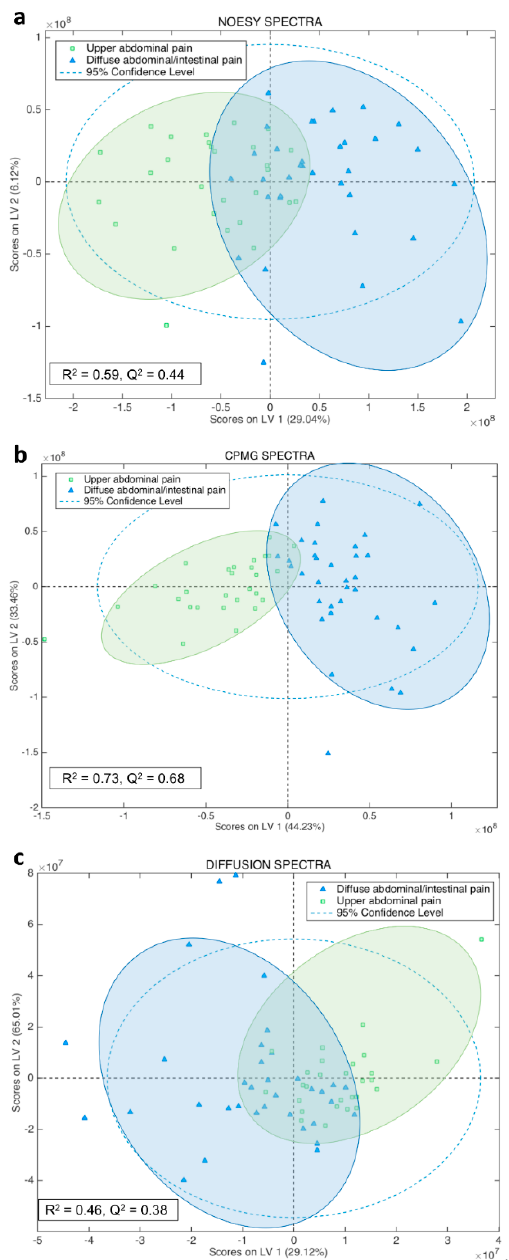
Figure 2. 2D score plots of the Orthogonal Partial Least Squares–Discriminant Analysis (OPLS-DA) classification of two groups of diseases according to their symptomatology, namely one group of digestive diseases causing sever upper abdominal pain (bile tract diseases) and one group of diseases expressed with diffuse abdominal/intestinal pain (bowel obstructive diseases). The OPLS-DA models are based upon ( a ) NOESY, ( b ) CPMG and ( c ) diffusion NMR spectra, respectively. The second latent variable (LV) is the orthogonal component. In addition, the R 2 , Q 2 values and the 95% confidence ellipse of each group are depicted.